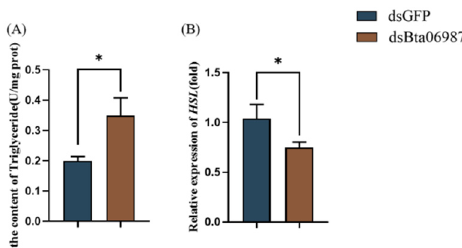
Figure 5. Triglyceride content and the relative expression of related gene. ( A ) The content of TAG. ( B ) The relative expression of HSL . The data are shown as means ± SE of three independent experiments. Significant differences based on Student’s t -test are denoted as * p < 0.05.